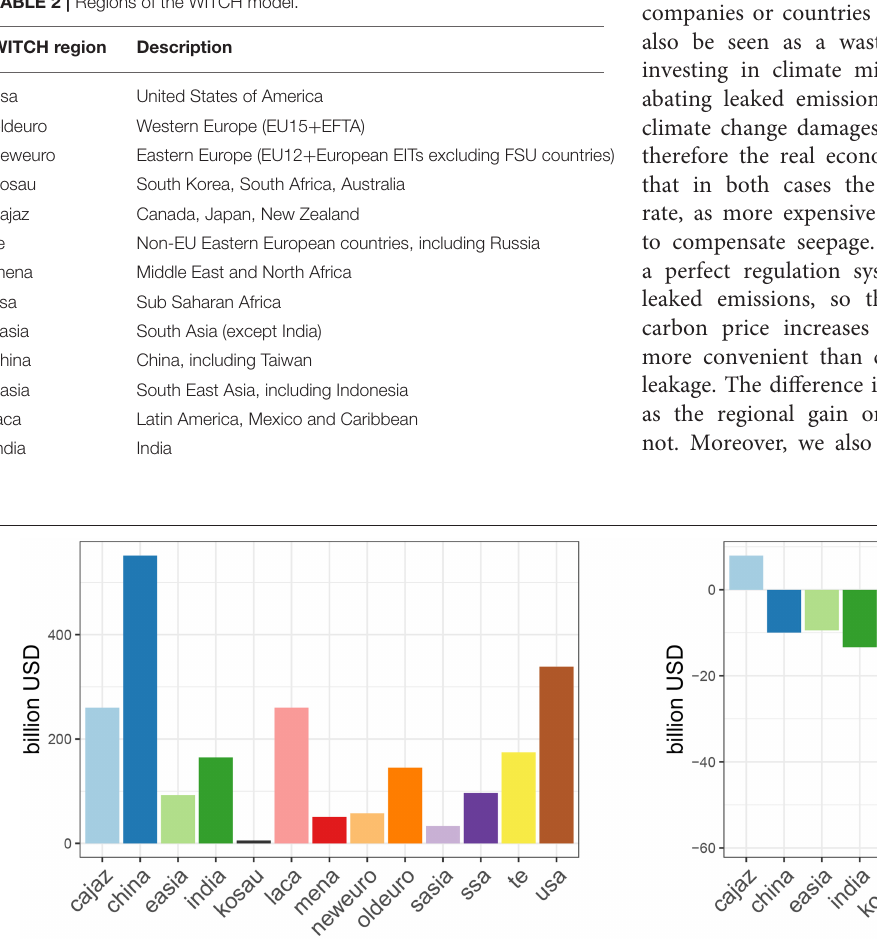
Frontiers in Energy Research |